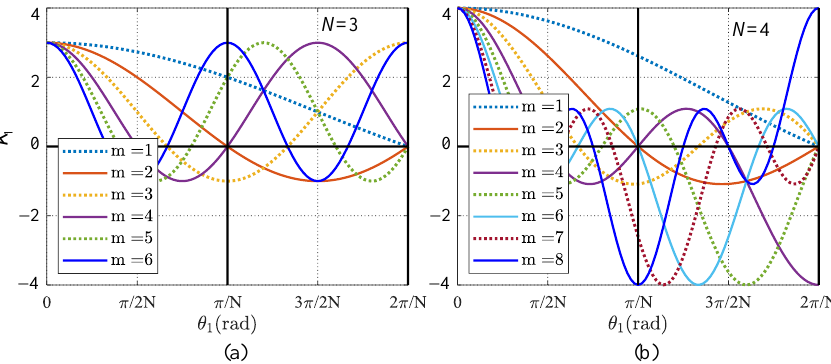
Figure 4. Harmonics of group cancellation characteristics with PSC-SPWM schemes. ( a ) N = 3. ( b ) N =